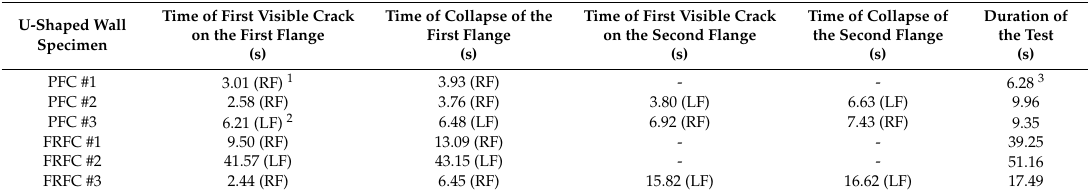
Table 2. Time period for the first visible crack and failure of the U-shape wall flanges. U-Shaped Wall Specimen